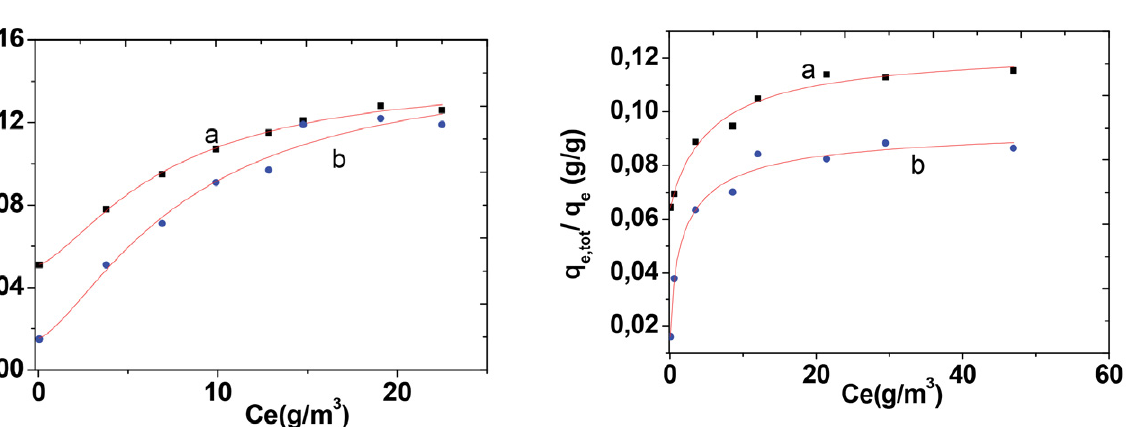
Figure 5. Adsorption Isotherms a- co-adsorption of ethanol – H 2 O; b- ethanol on Adsorbent 3 (rH = 46%, t = 25 °C)